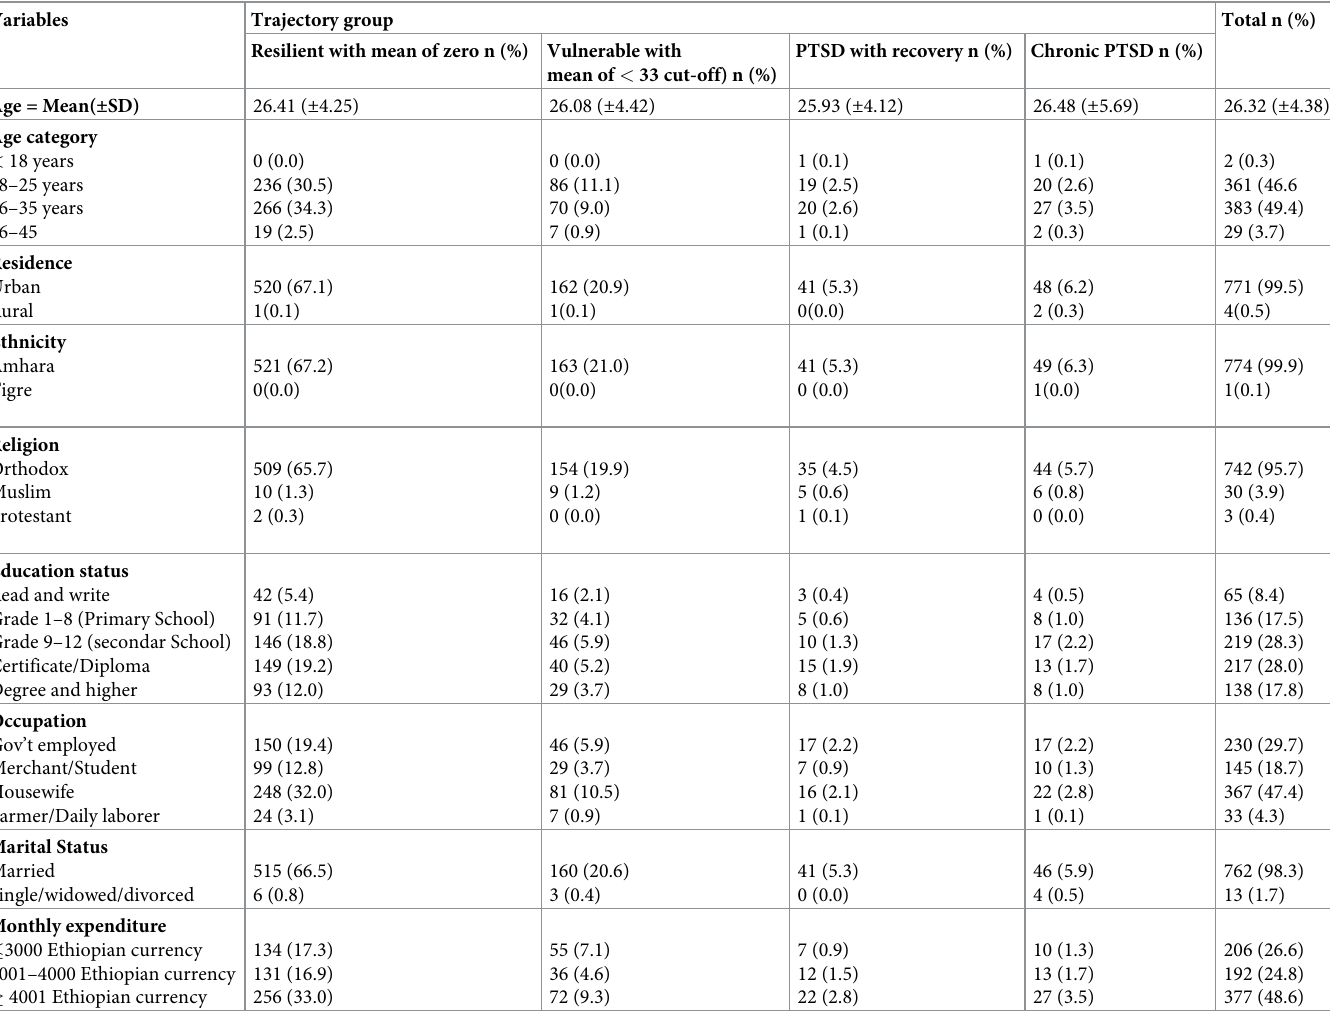
Table 1. Socio-demographic characteristics of postpartum women by PTSD trajectory groups in Northwest Ethiopia, 2021.